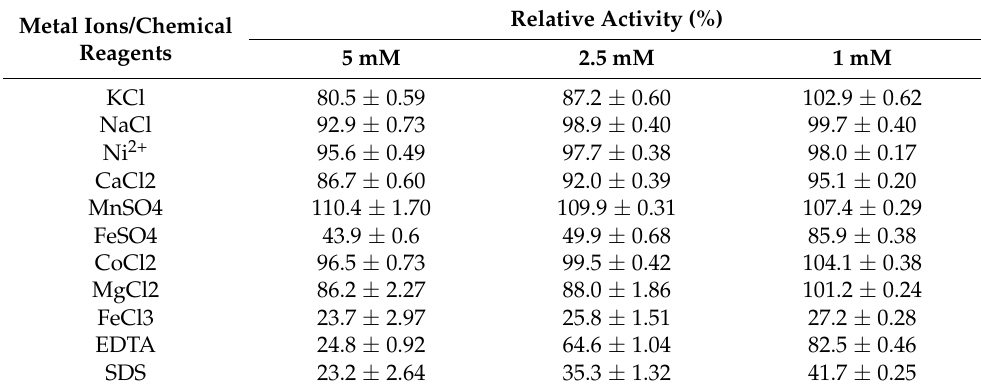
Table 1. Effects of metal ions and chemical reagents on the activity of XynST7.